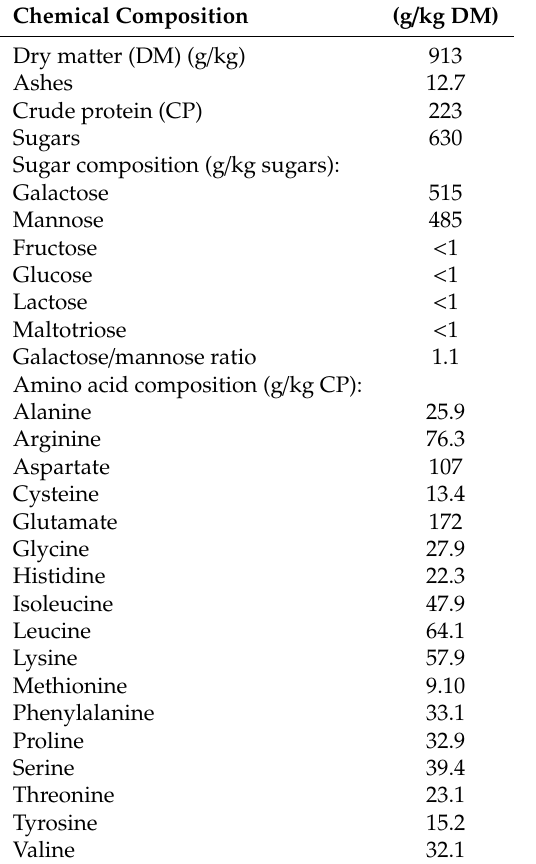
Table 2. Chemical composition of fenugreek gum.